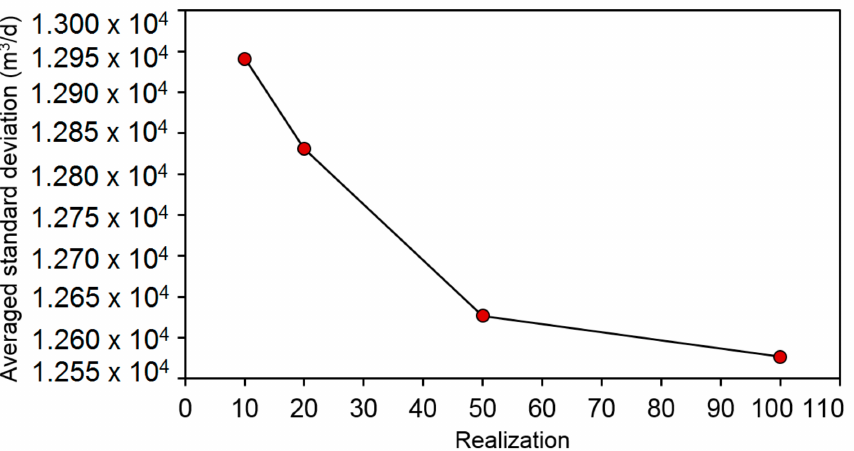
Figure 11. The averaged standard deviation related to the selected realizations using the Monte Carlo simulation model for interflow